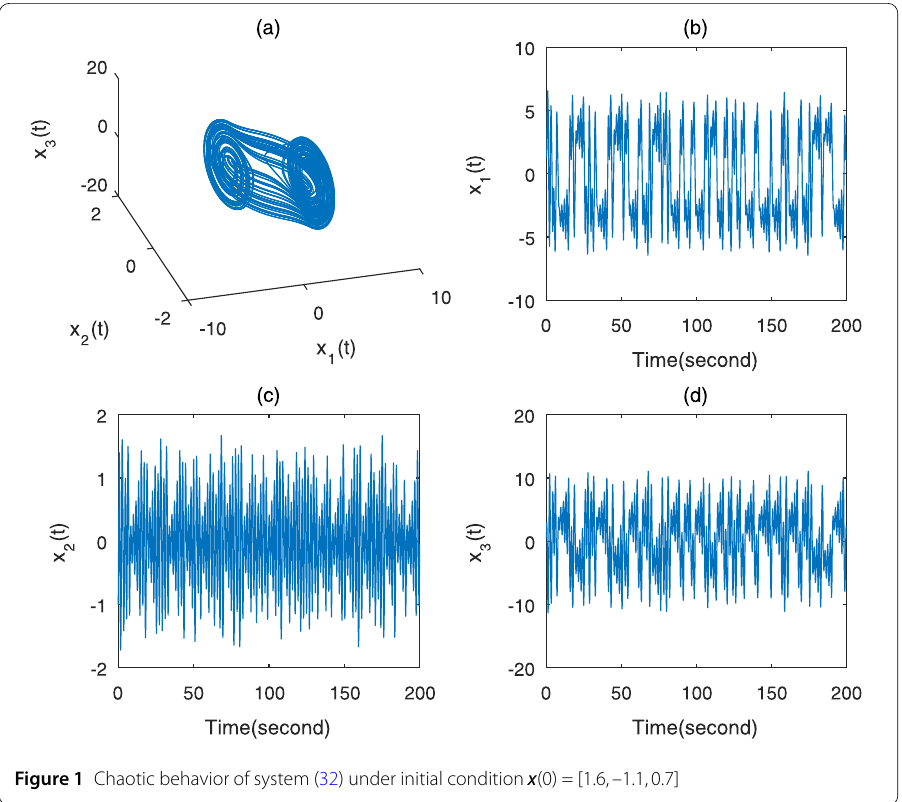
Figure 1 Chaotic behavior of system (32) under initial condition xxx (0) = [1.6,–1.1,0.7]